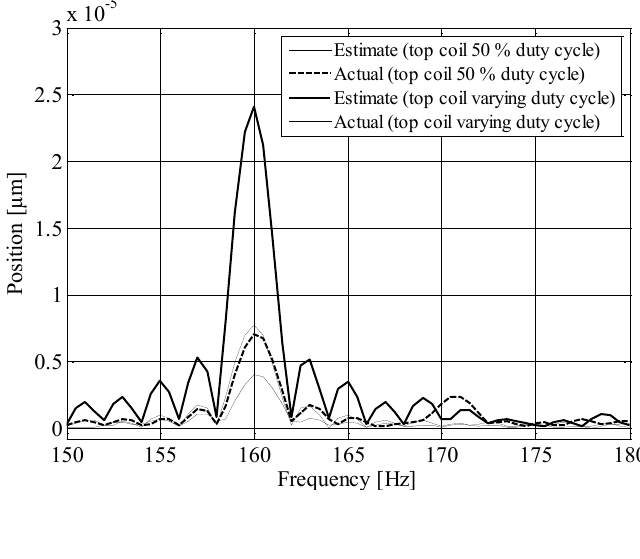
Figure 15. FFT position plots illustrating magnetic cross-coupling